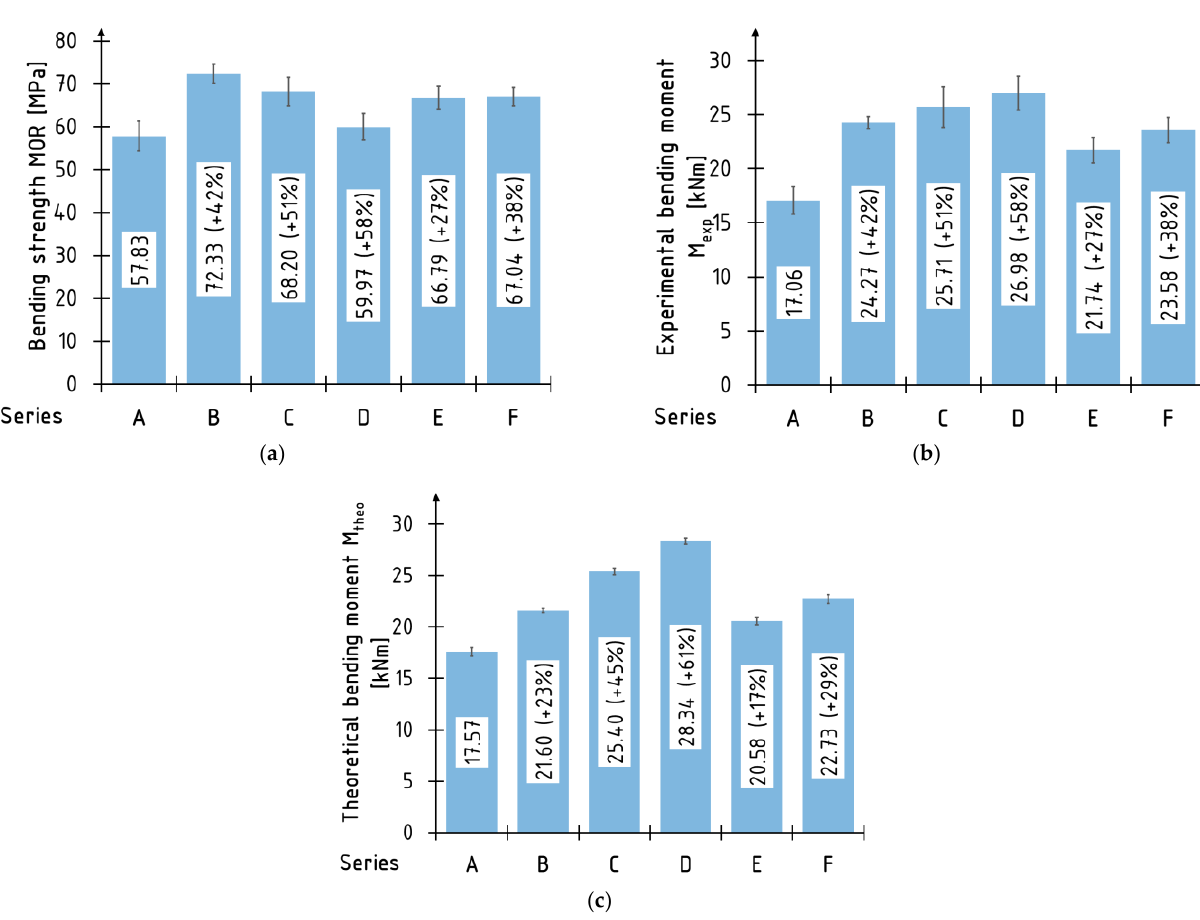
Figure 6. Average values of: ( a ) modulus of rupture (MOR); ( b ) experimental bending moment M ; ( c ) theoretical bending moment M theo .